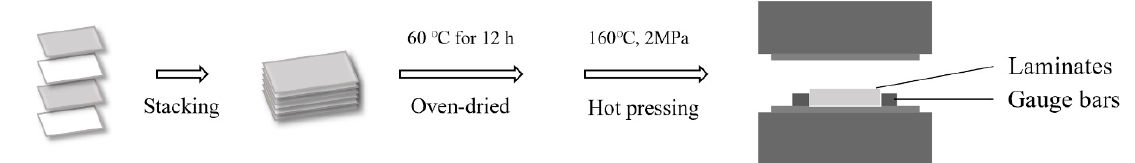
Figure 1. Schematic diagram of newspaper (NP) / high-density polyethylene (HDPE) laminated composites fabrication.